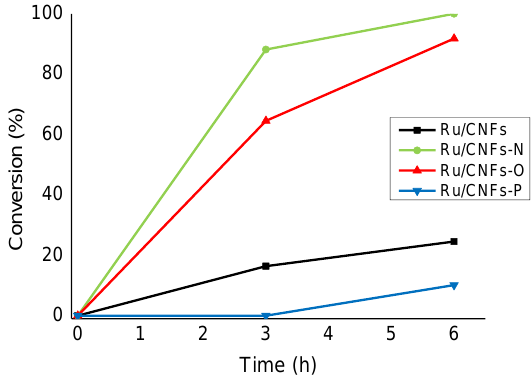
Figure 3. Change in activity in the LA hydrogenation reaction on the different catalysts tested. All the substrate selectively converted to GVL (selectivity > 99%). Reaction conditions: LA, 0.3 M, substrate/metal = 1000 mol/mol, solvent, 15 mL H 2 O, 100 °C, 7 bar H 2 .